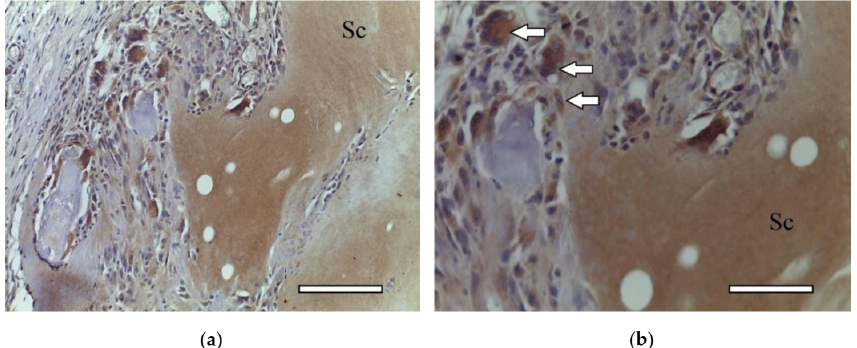
Figure 12. 1st group (dECM only), 2 weeks. Collagen type II in the cytoplasm of multinucleated cells of foreign body resorption and macrophages (arrows) in the connective tissue capsule. Diffuse background—scaffold material (Sc). Staining for type II collagen (asterisk). ( a ) objective lens × 20, scale bar—100 µ m; ( b ) objective lens × 40, scale bar—50 µ